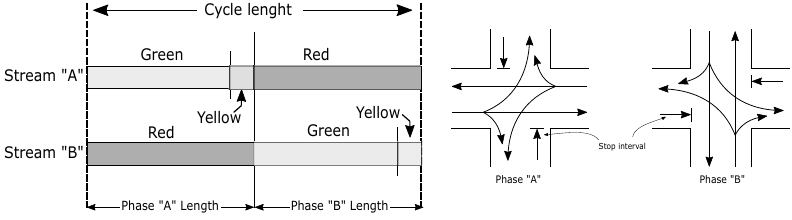
Figure 1. Phase-cycle traffic signal